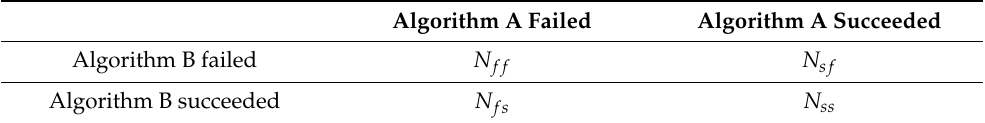
Table 8. Possible results of algorithms. (Illustrations by the